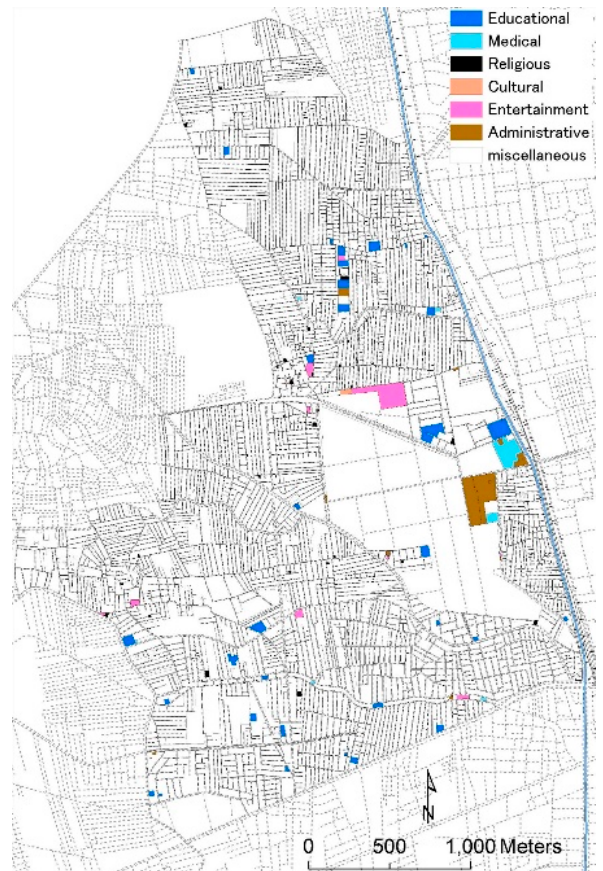
Figure 7. Services in Boulaq.